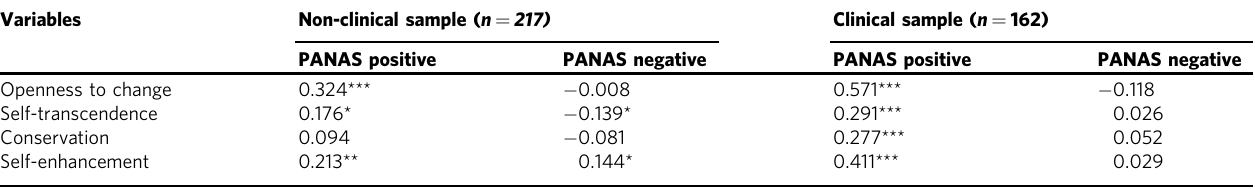
Table 3 Pearson correlations coef fi cient between PANAS and PVQ values in the non-clinical and clinical sample.